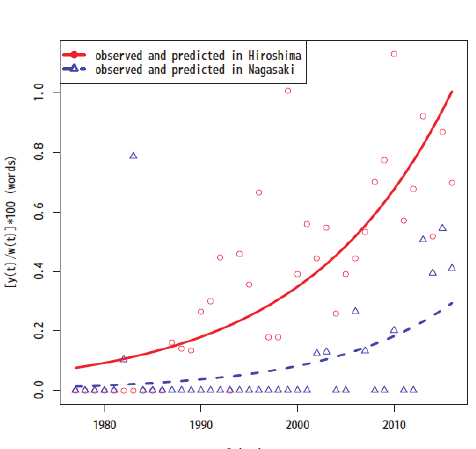
Fig. 1. Observed and predicted frequencies of "hibakusha"